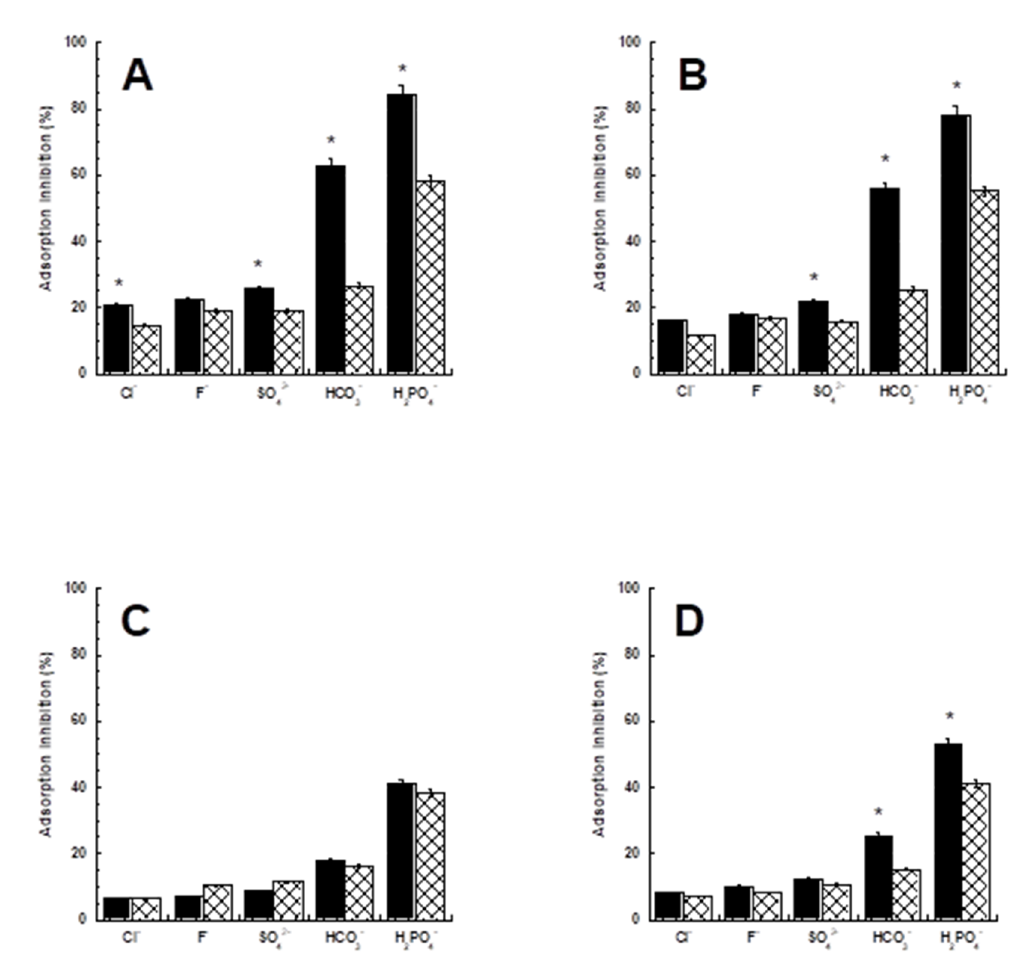
Figure 3. Inhibition (%) of As(III) (black bars) and As(V) (checkered bars) adsorption by competing inorganic anions from Zn-Al ( A ), Mg-Al ( B ), Cu-Al ( C ) and Mg-Fe ( D ) layered double hydroxides, after 24 h of reaction at pH = 7 and 20 °C. Initial anion/As(V) ratio equals to 3, with 50% of surface coverage. Asterisks indicate significant differences according to one-way ANOVA, HSD Tukey test ( p < 0.05).